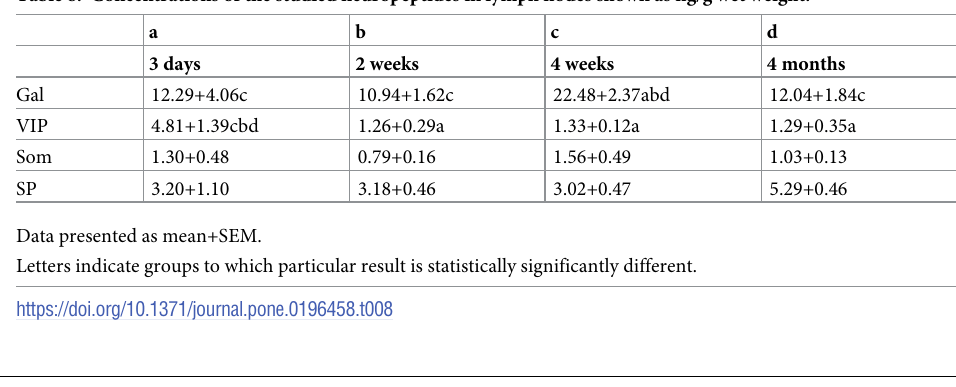
Data presented as mean+SEM. Letters indicate groups to which particular result is statistically significantly different.